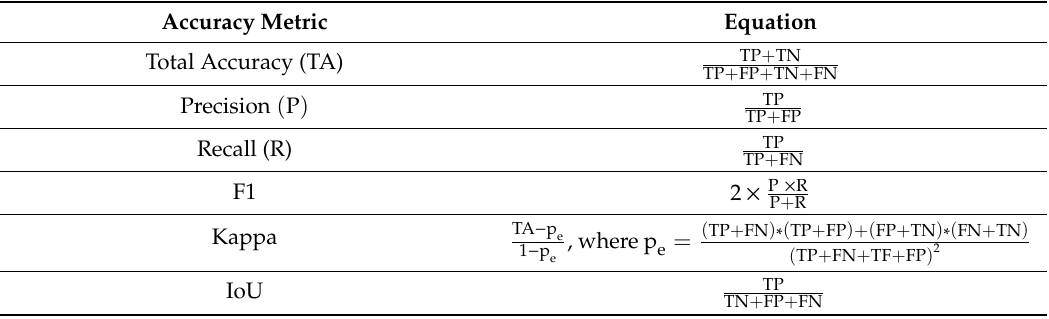
Table 3. Summary of accuracy metrics used in the object detection, where TP is true positive, TN is true negative, FP is false positive, and FN is false